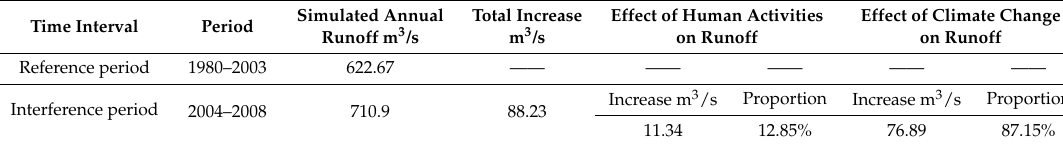
Table 7. Simulated response of human activities and climate change in Heihe River Basin.